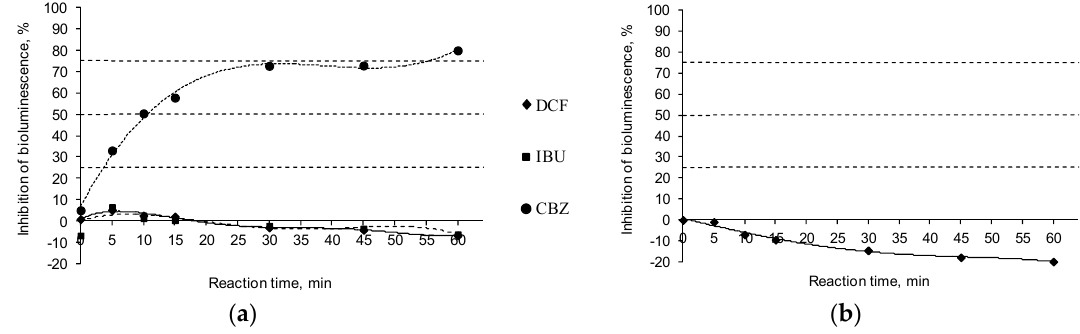
Figure 5. Change in toxicity of ( a ) deionised water suspensions and ( b ) model WWTP effluent.